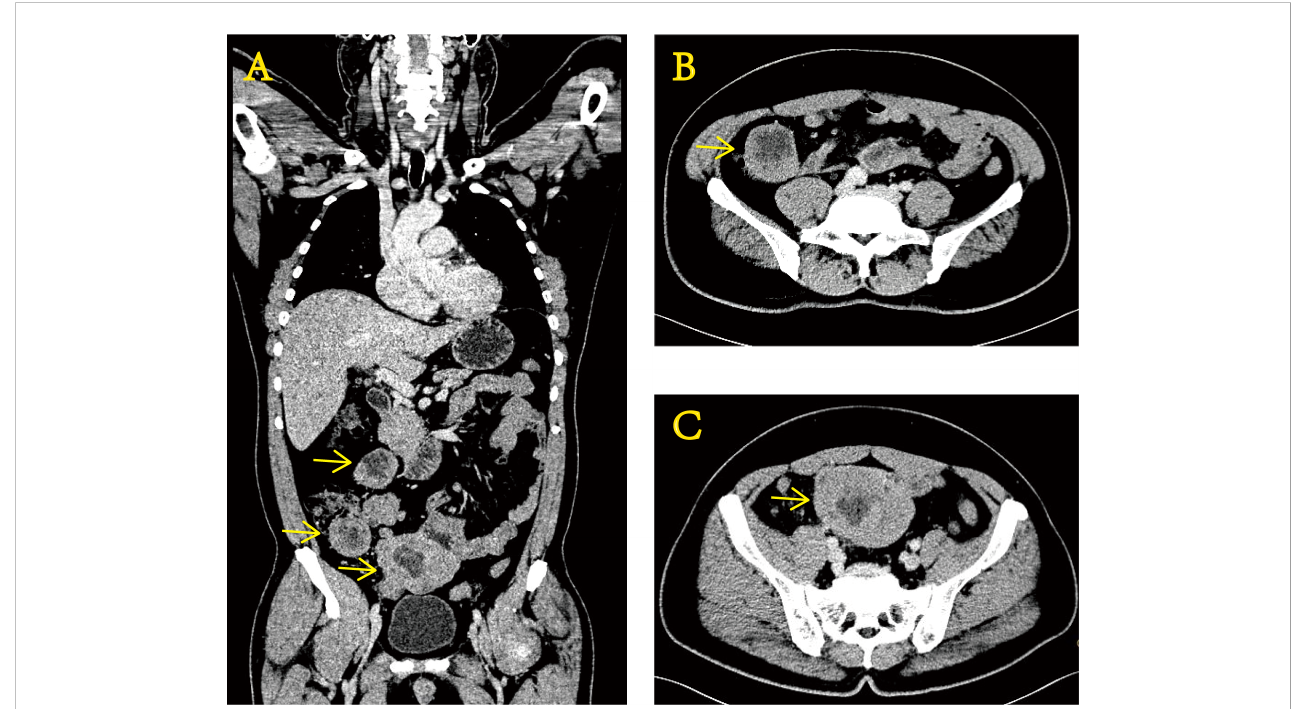
FIGURE 1 Enhanced CT images of the abdomen at the time of initial diagnosis show uneven thickening of the terminal ileum wall. Coronal section (A) and transverse section (B, C)